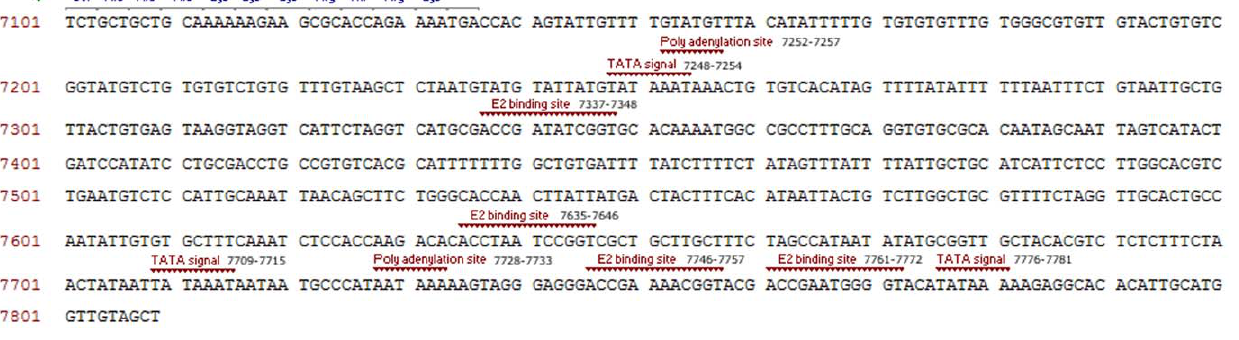
Figure 3. Characteristic features of the long control region (LCR) of HPV-125. The genomic locations of E2 binding sites (ACC-N 5–7 -GGT), polyadenilation sites (AATAAA), and TATA signals (TATAAA or TATA(A/T)A(A/T)) are indicated on the coding strand. doi:10.1371/journal.pone.0022414.g003 PLoS ONE |